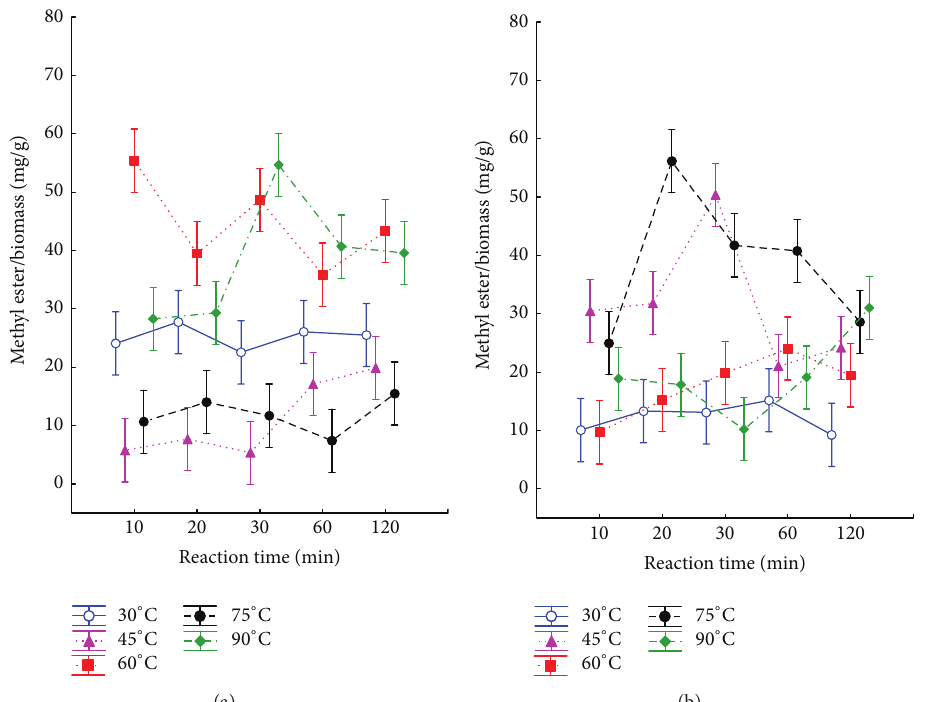
Figure 1: Mass of methyl ester obtained in the in situ reaction with chloroform (a) and hexane (b).